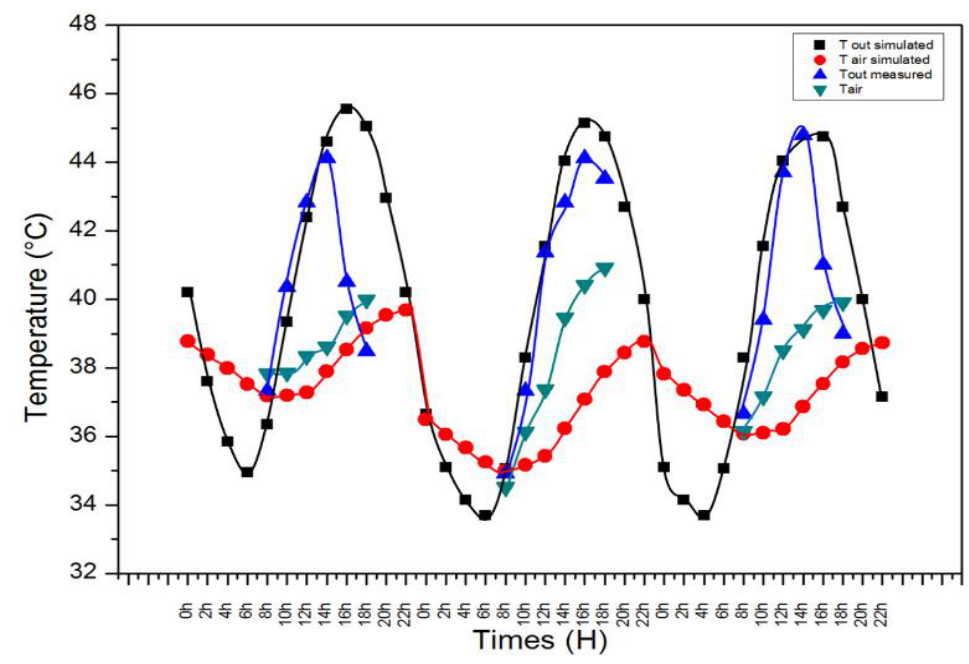
Figure 7. Measured and simulated indoor and outdoor air temperatures during the hottest three days in July. Table 4. Validation criteria values of the simulation model.